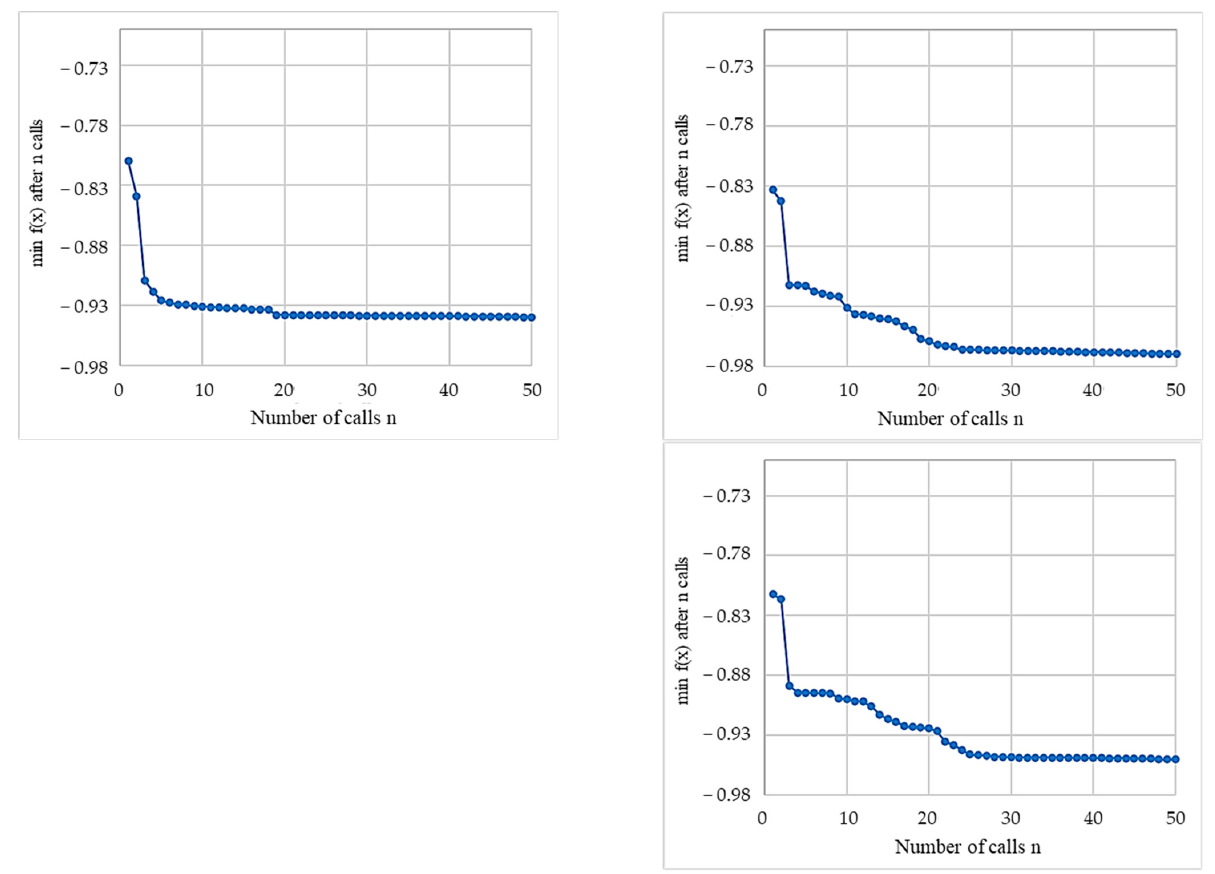
Figure 9. Convergence plots showing the progress of Bayesian optimization of MRS parameters with 2D CNN, 3D CNN, and HybridSN models.